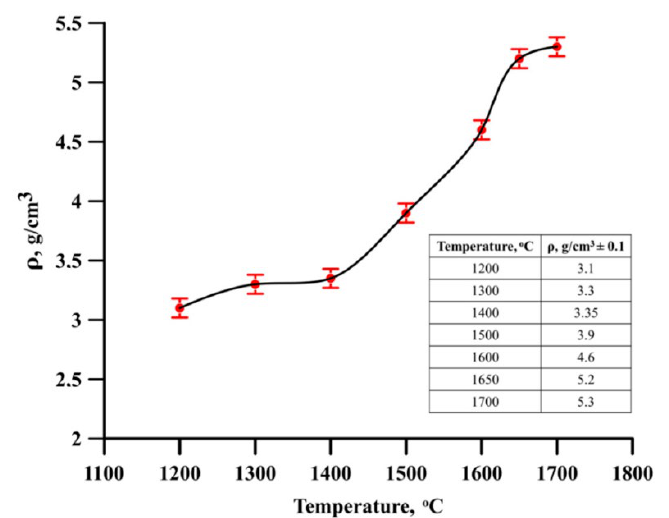
Figure 2. Density vs. sintering temperature curve for the NiTi -TiB 2 samples.